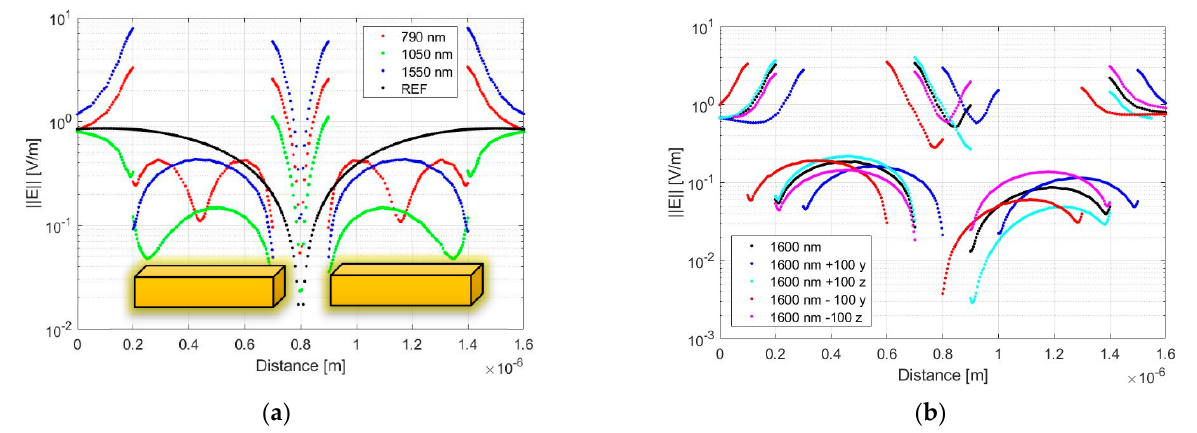
Figure 4. ( a ) Linear antenna in a plane with the incident beam; the black line describes the incident electric field, and the blue line illustrates the electric field produced with an incident beam wavelength of 1550 nm, corresponding with the main resonance. The green line is produced with an incident beam wavelength of 1050 nm close to antiresonance, and the red line is produced with an incident beam wavelength of 790 nm close to the second resonance. ( b ) Linear antenna at 45°, slanted plane; the black line is the field produced by a beam with a wavelength of 1600 nm, and it is not a symmetrical profile; the red and blue lines are the effect of shifting the antenna 100 nm in the y- direction, where a positive movement helps the symmetry. Cyan and magenta lines are the effect of moving the antenna in the z -direction, where a negative movement also helps the symmetry.